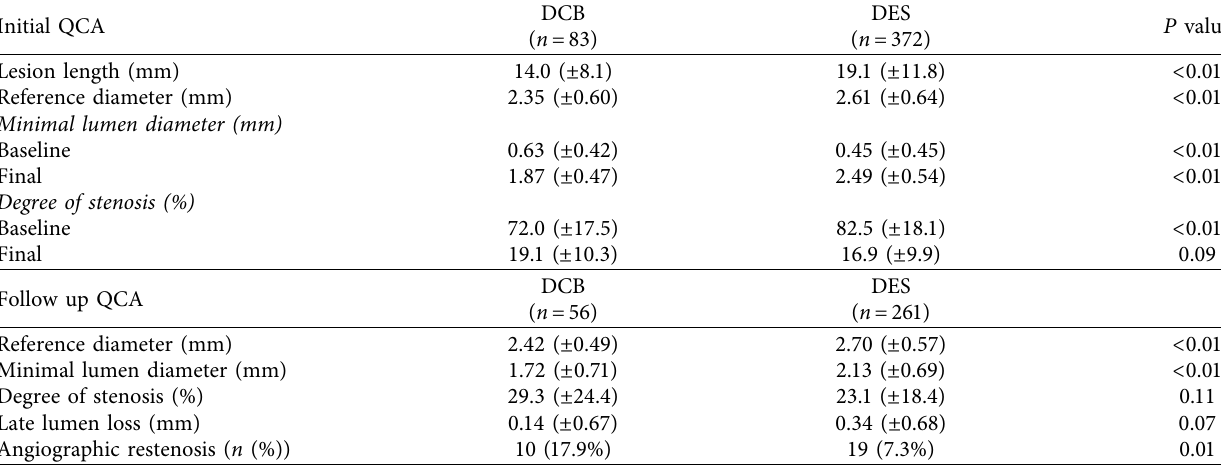
Table 3: Initial and follow up quantitative angiographic results.